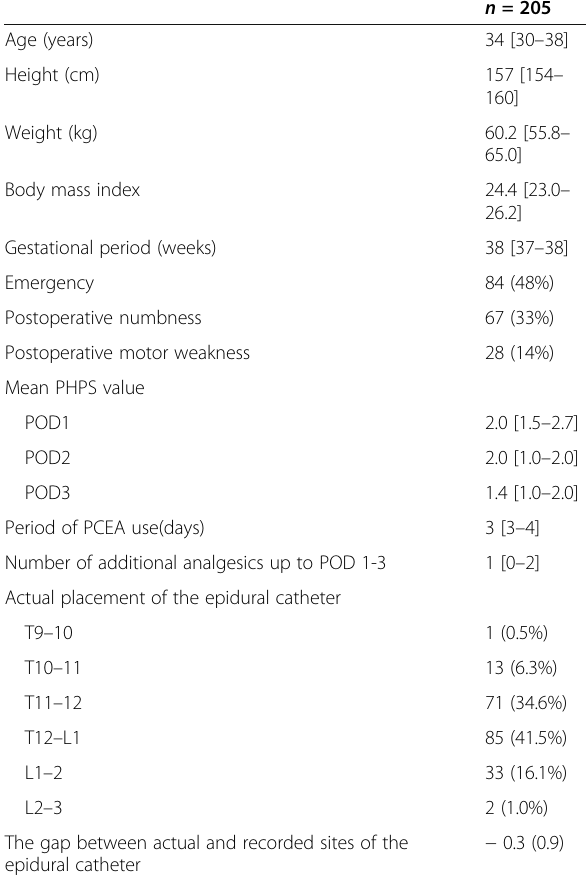
Table 1 Characteristics of patients who received cesarean section with